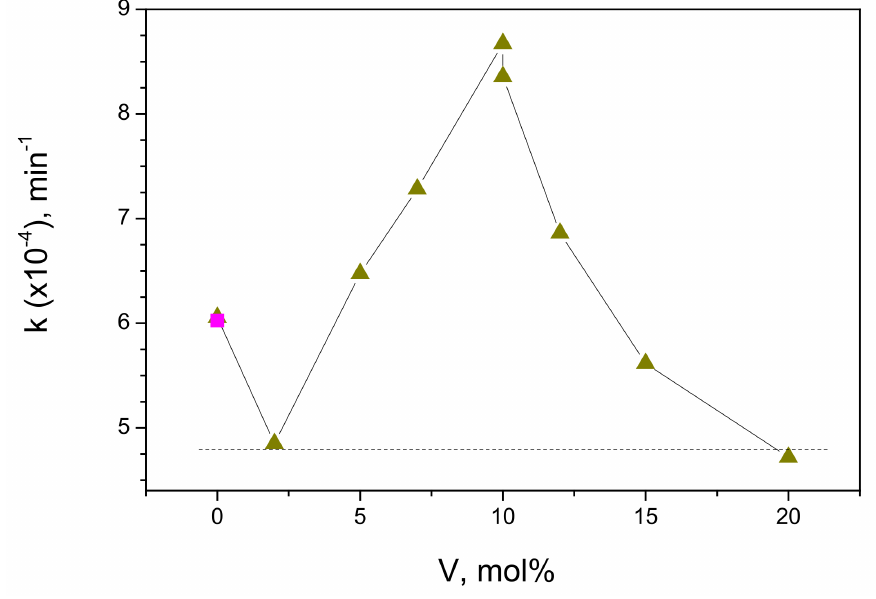
Figure 11. Rate constant of MB decomposition with VIS lamp illumination ( λ > 385 nm) versus vanadium content on V-TiO 2 coated glass beads. Rate in empty reactor (due to photolysis) is shown by “filled square”